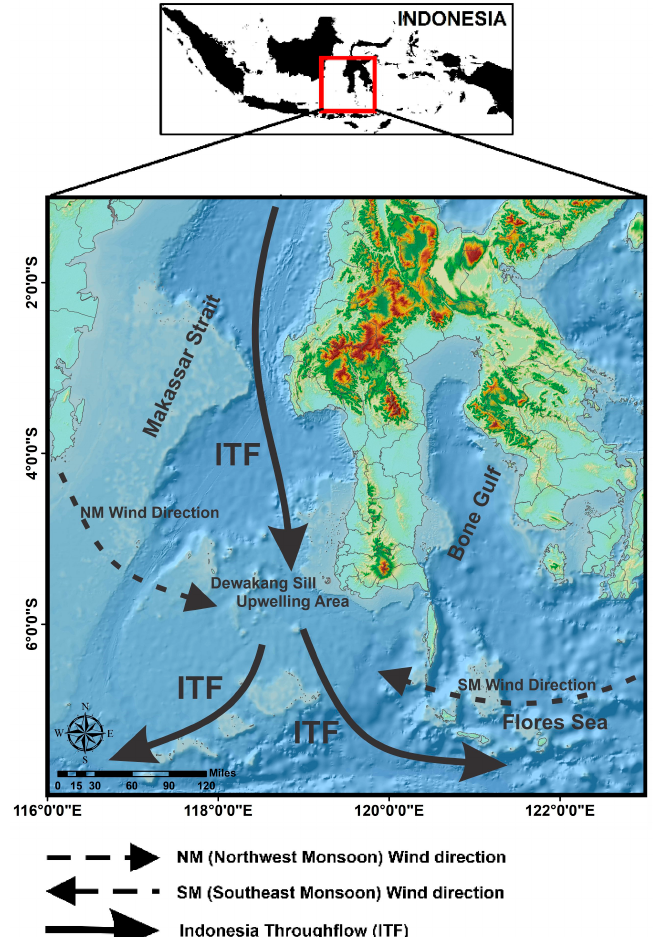
Figure 1. The map of the study area, illustrating the major environmental characteristics of Indone- sia Fisheries Management Area (IFMA) 713 (1–8°S and